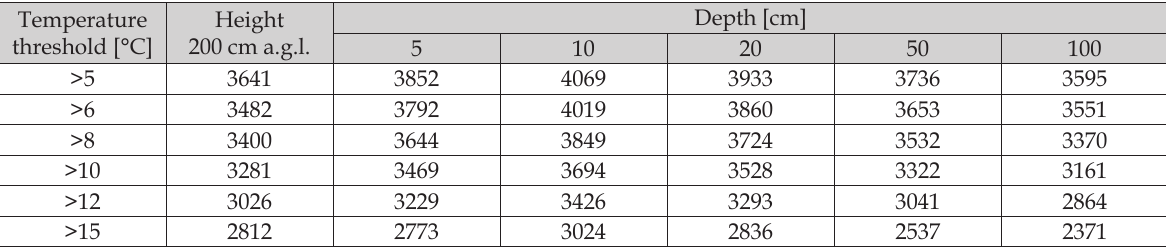
Table 8. The sum of air temperature and soil temperatures (°C) at various depths in Poznań in years 2011–2020.